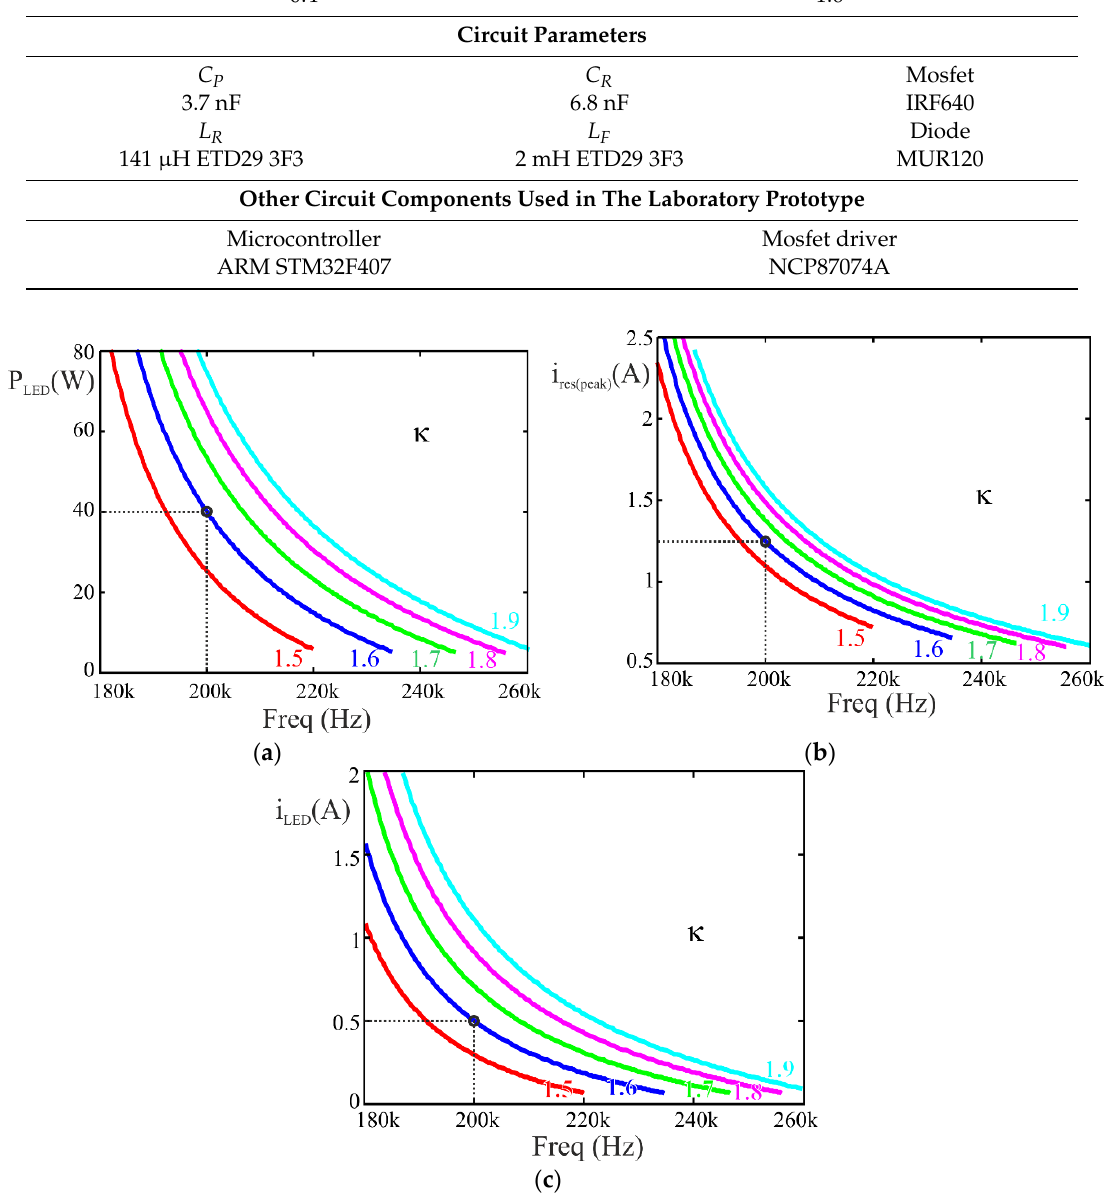
Figure 6. Theoretical evolution against changes in the operating frequency: ( a ) output power; ( b ) light-emitting diode (LED) current; ( c ) resonant current (peak value).